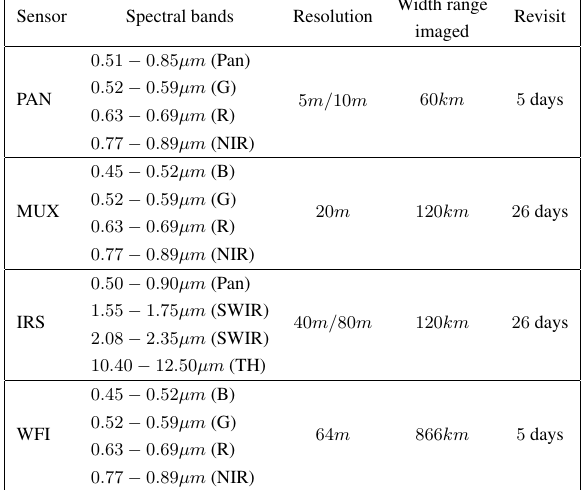
Table 1. Summary of the characteristics of the CBERS-4 sensors. Source: http: //www.cbers.inpe.br/sobre/cameras/cbers3-4.php The CBERS-4 data cube was created using images from the WFI sensor. The WFI images have 64m of spatial resolution and the raw data are processed to produce co-registered, top of atmosphere and surface reflectance ARD images (Dwyer et al., 2018). Also, the indices NDVI and EVI, and a cloud mask product are computed (Figure 1). From surface reflect- ance product, we generate composite images using different time periods, one month and 16 days. These periods